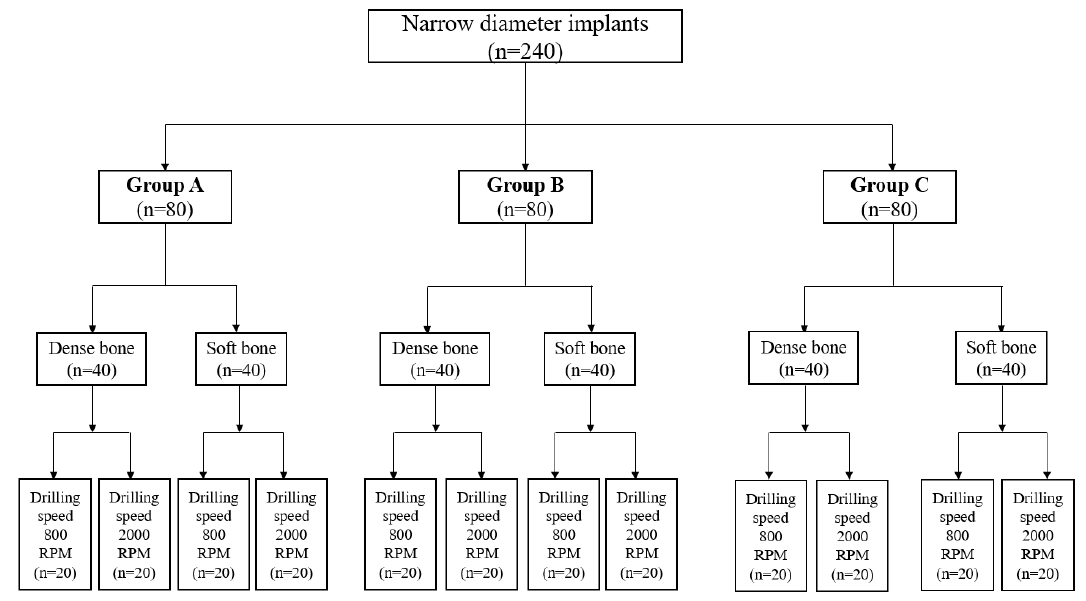
Figure 2. A schematic of the distribution of narrow diameter implants placed in dense and soft artificial bone in Groups A, B, and C.